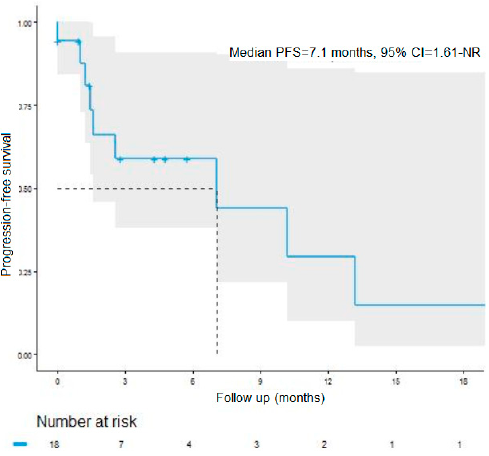
Figure 2. Progression-free survival in the BRAF-wild type subgroup. PFS: progression-free survival; NR: not reached. NR: not